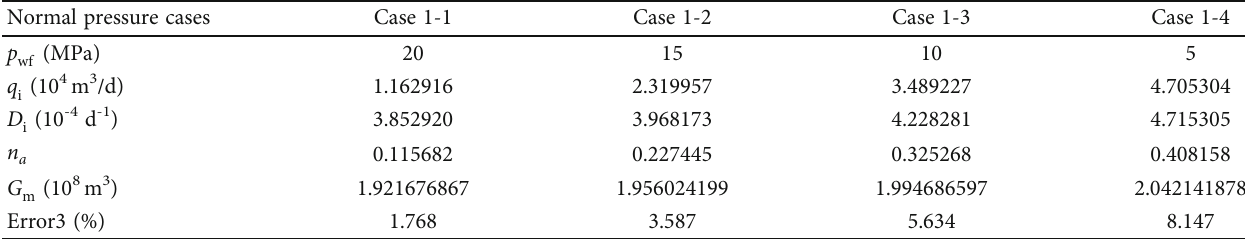
(b) The analysis results of the modi fi ed Stumpf method for numerical cases with normal pressure Normal pressure